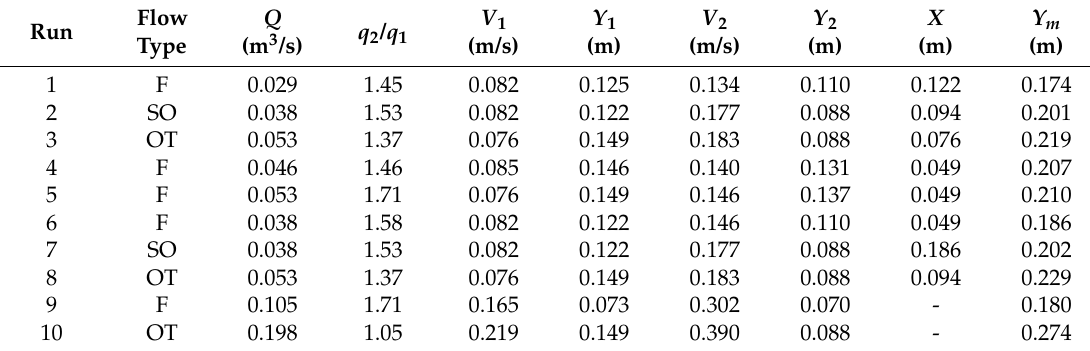
Table 1. Experimental conditions and location of maximum scour depth